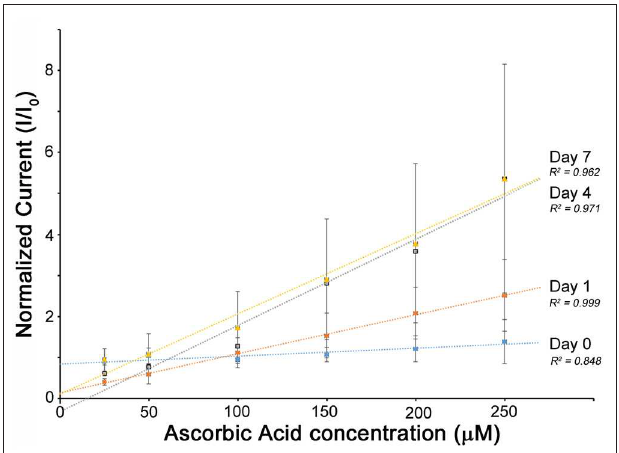
FIGURE 4 | The electrochemical performance of the O3E flexible biosensor when stored in 1 unit ml − 1 of protease solution at 37 ◦ C. The sensors were monitored over a period of 1 week. The control sample was PBS ( I nor = 1). It may be noted that after 10 days, the sensors begin to lose mechanical integrity at the macroscale and are not easily connected for reliable measurements. The relatively high error bars can be explained by sensor-to-sensor variability obtained during averaging of the signals from three separate sensors.